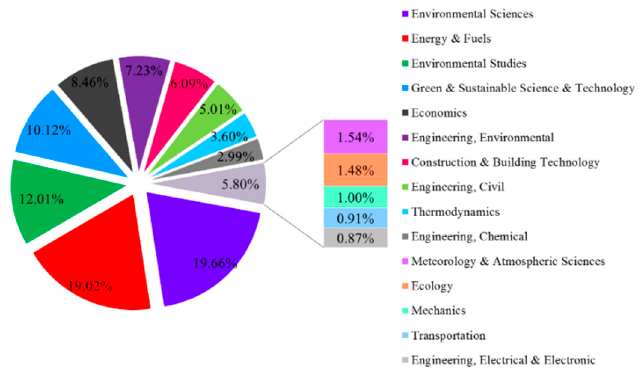
Figure 4. Top 15 productive categories of HCEs.